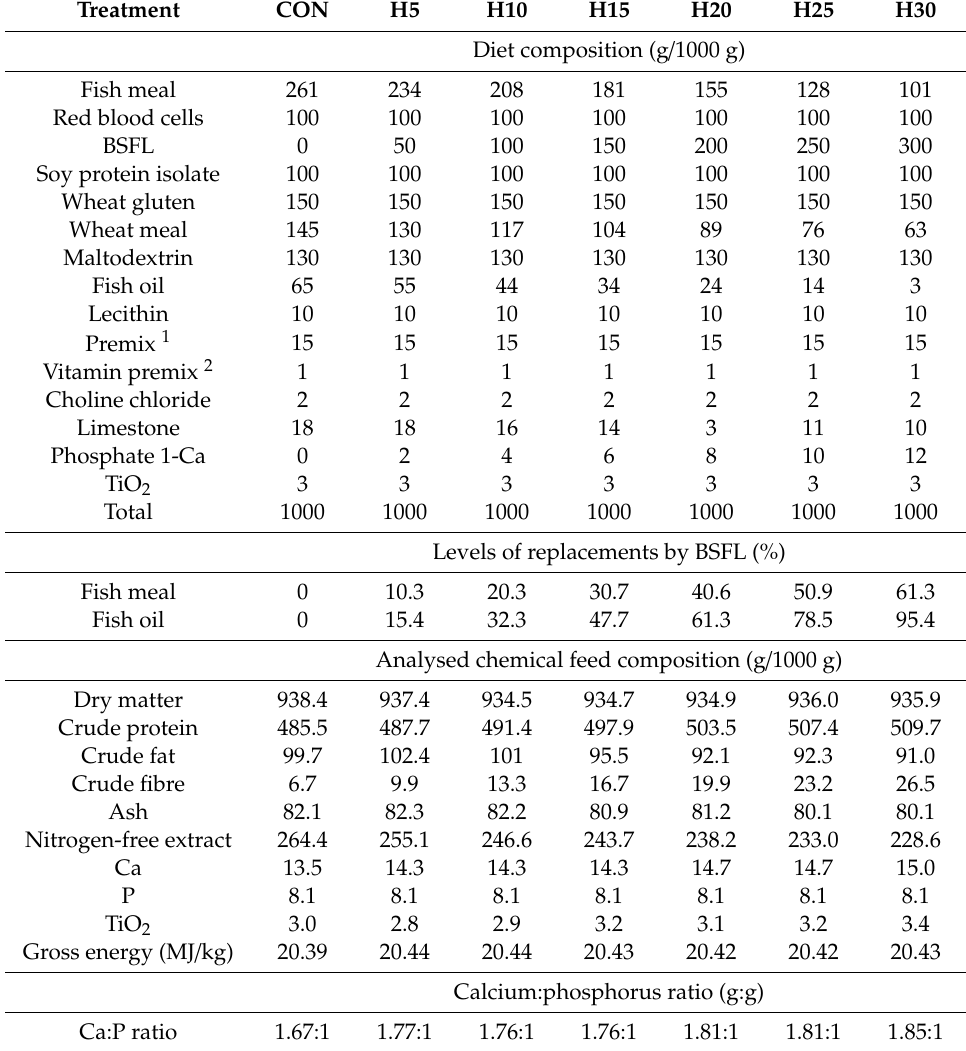
Table 3. Compositions and proximate chemical analysis of experimental diets.